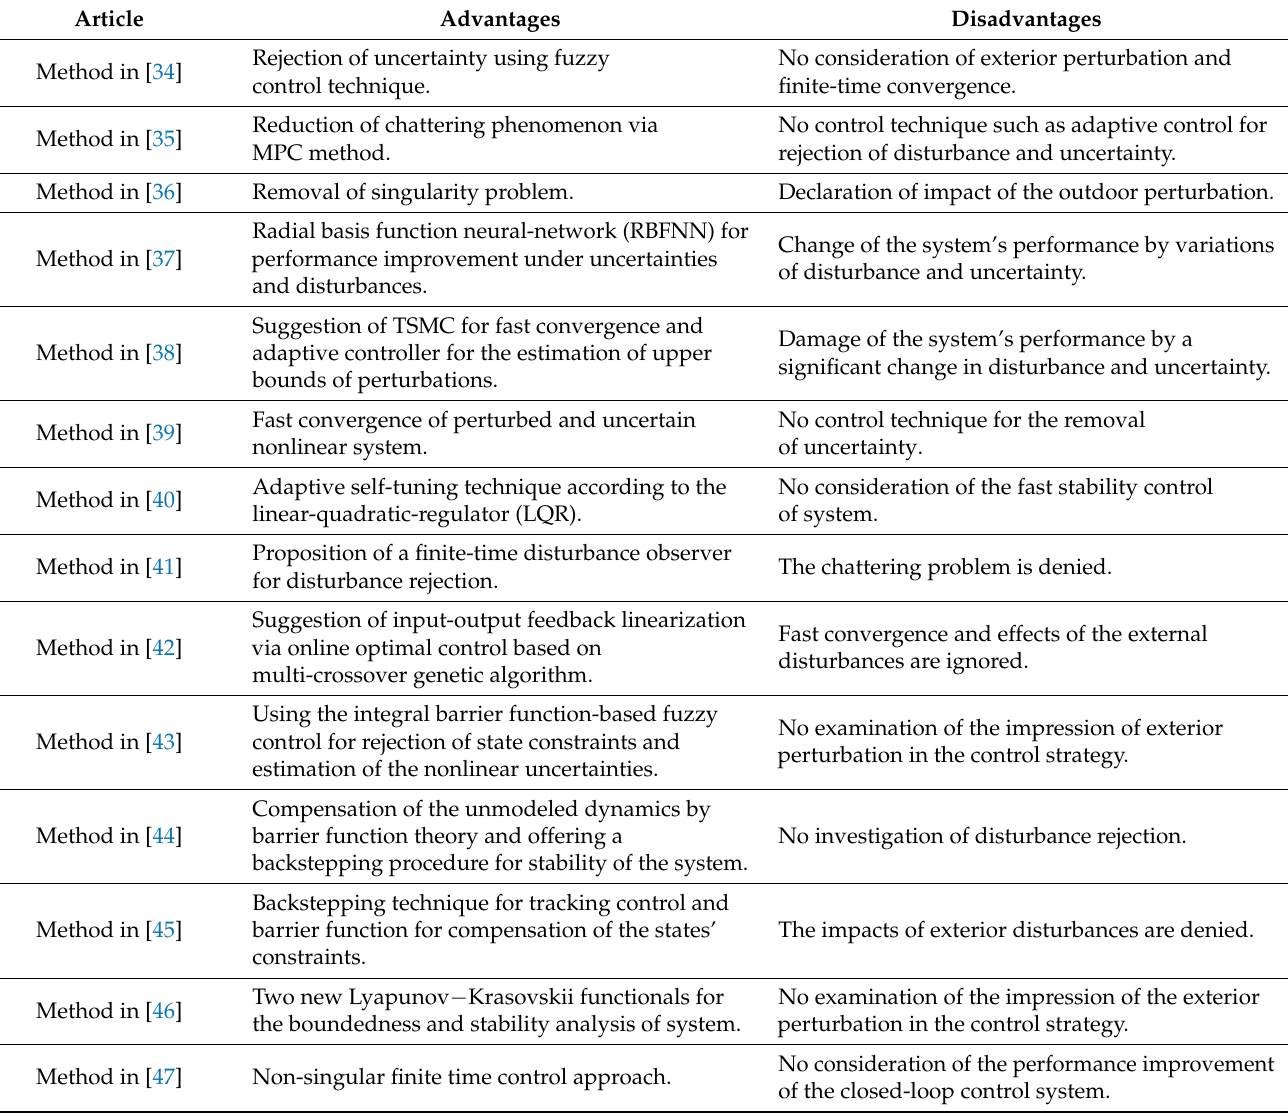
Table 1. Comparison of the proposed method with other research